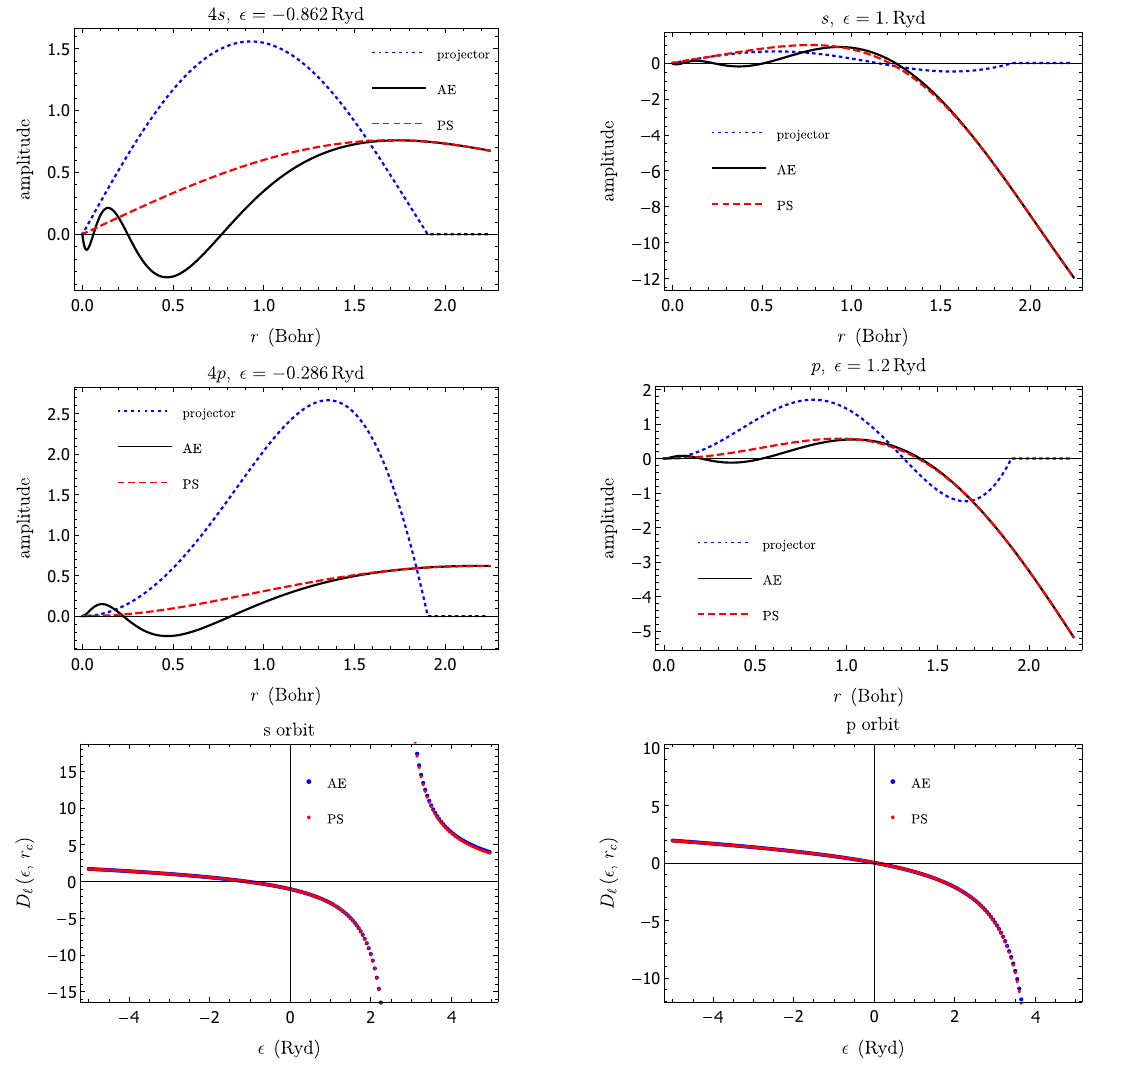
Figure 2 . Radial partial waves and energy derivatives for germanium. Shown in the first (second) row are two sets of AE ( black solid ), PS ( red dashed ) partial waves and projectors ( blue dotted ) for angular momentum ℓ = 0 (1), respectively, and in the third row the energy derivatives of the AE ( blue ) and PS ( red ) partial waves for ℓ = 0 (1) are also presented. See text for